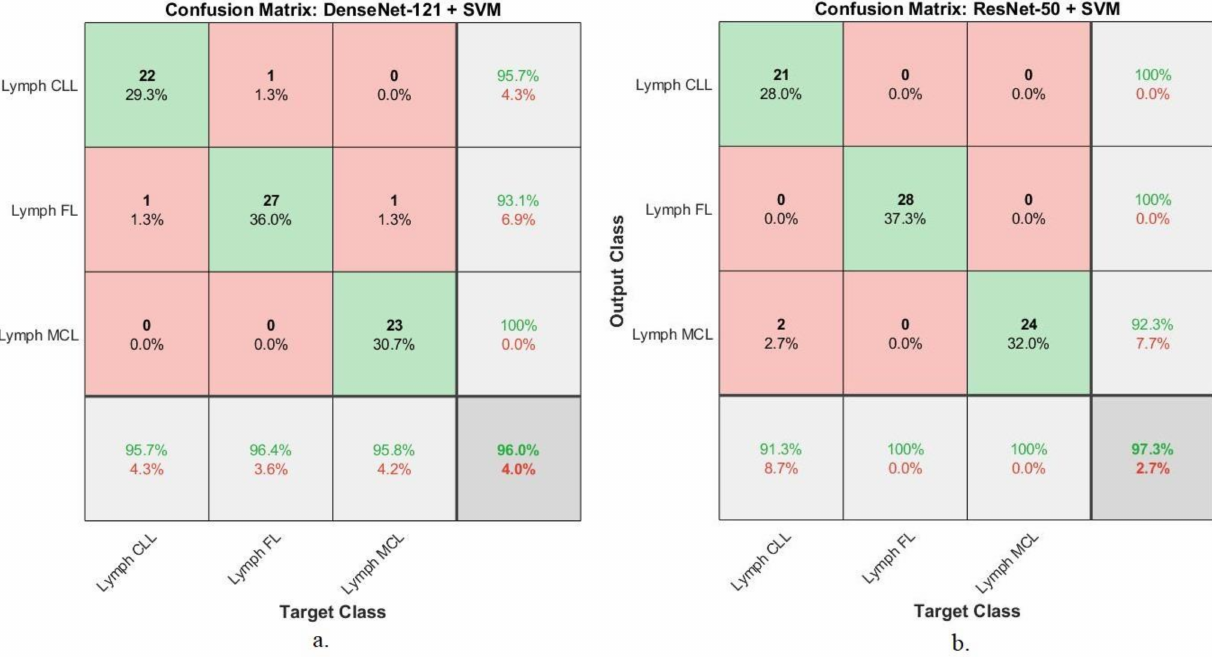
Figure 8. The confusion matrix displaying the diagnosis of malignant lymphomas of the second dataset by: ( a ) DenseNet-121 + SVM and ( b ) ResNet-50 +